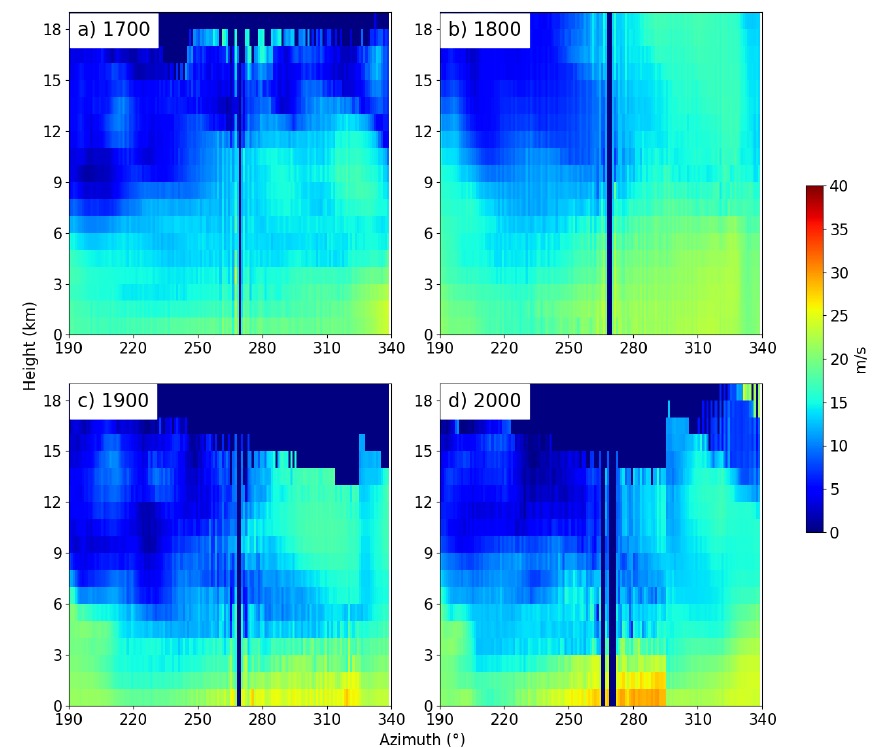
Figure 12. Variation of the tangential wind range mean (color shading) of the stratiform sector of outer rainband at azimuth 190–340° with horizontal radius of 20–60 km outward from the Typhoon Higos center with altitude at ( a ) 17:00, ( b ) 18:00, ( c ) 19:00 and ( d ) 20:00 UTC. The vacancy at azimuth around 270° indicates that averaged tangential wind cannot be obtained.